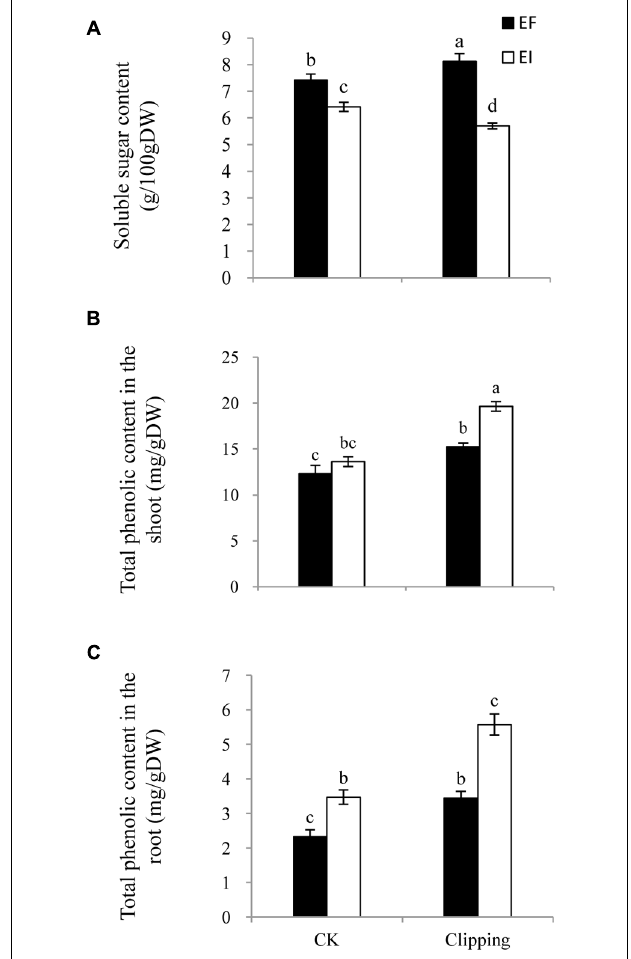
FIGURE 4 | Comparison of soluble sugar content (A) , total phenolic content in the shoot (B) and the root (C) of EF and EI A. sibiricum under unclipping (CK) and clipping treatments. Different lower-case letters denote means that are significantly different ( P <